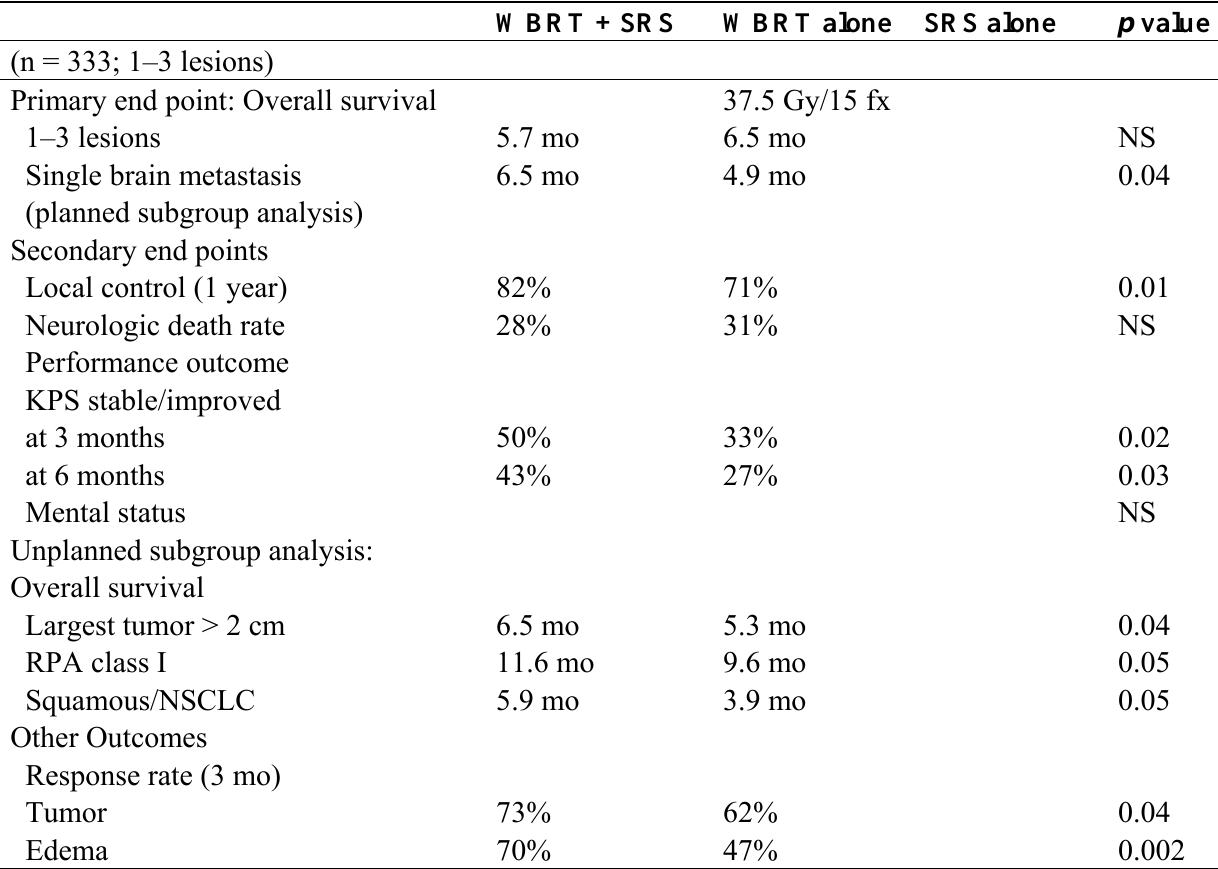
Table 5. Randomized study of SRS boost for patients with brain metastases, Radiation Therapy Oncology Group (RTOG) 95-08. WBRT + SRS WBRT alone SRS alone p